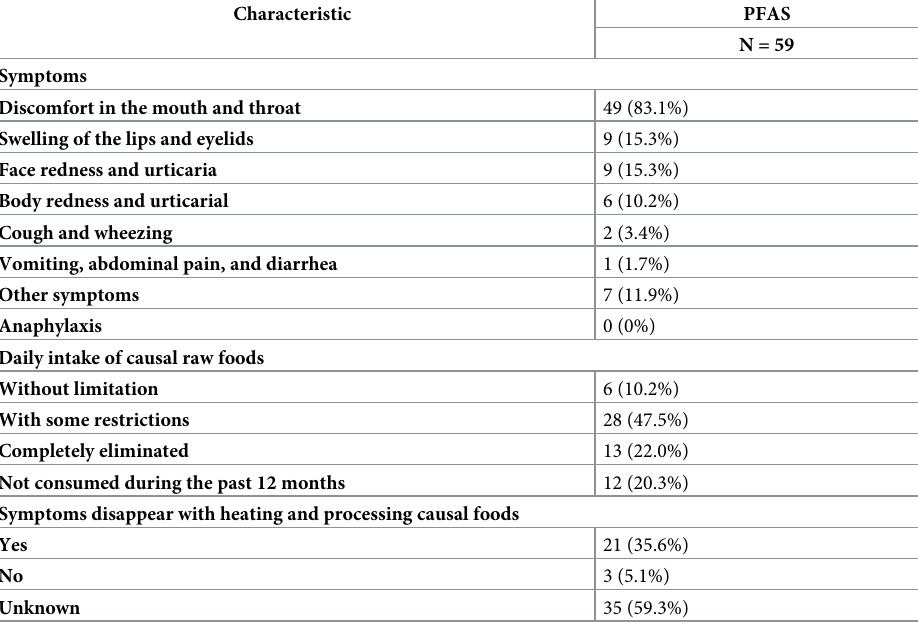
Table 7. Symptoms and causal food allergens in adolescents with PFAS.